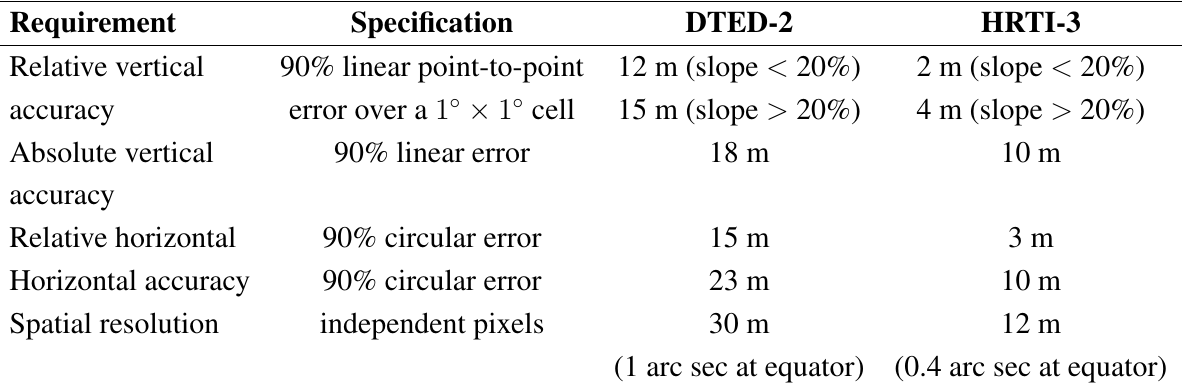
Table 5. Comparison of Digital Terrain Elevation Data (DTED-2) [591] and High Resolution Terrain InformationiHRTI-3) specifications